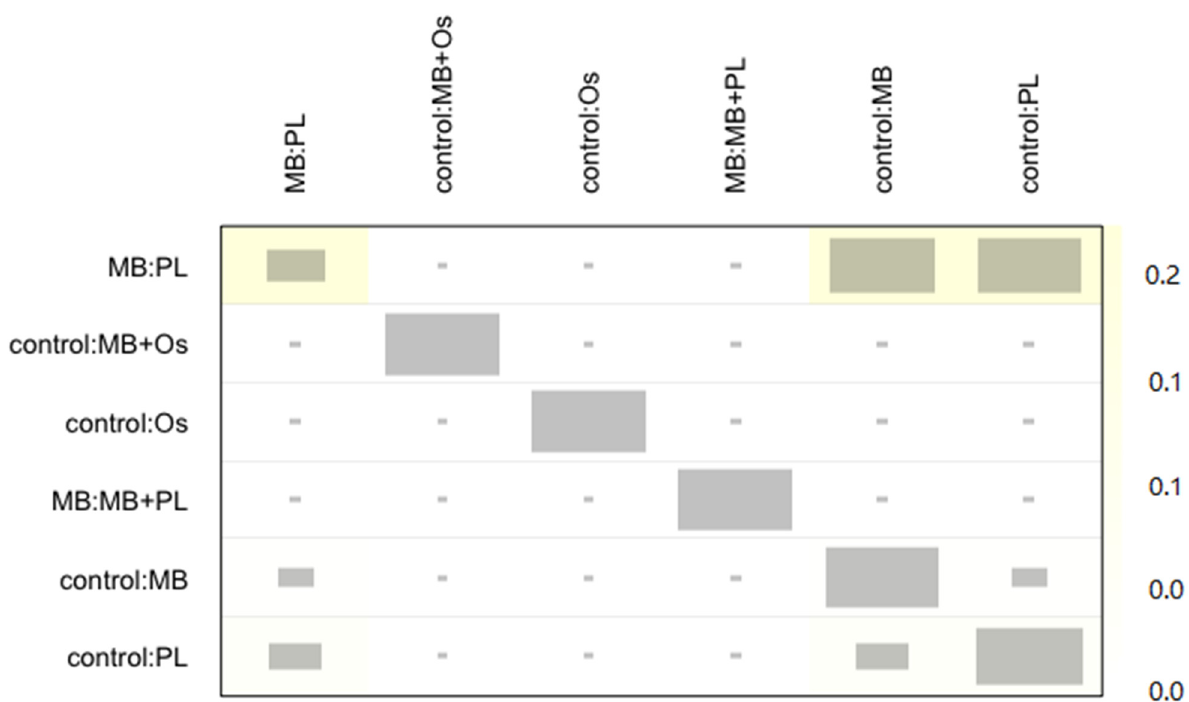
Figure 7. Net heat plot. Gray boxes signify the importance of one treatment comparison to the estimation of another treatment comparison. Larger boxes indicate more important comparisons. Color background, ranging from blue to red, signifies the inconsistency of comparison (row) attributable to design (column).